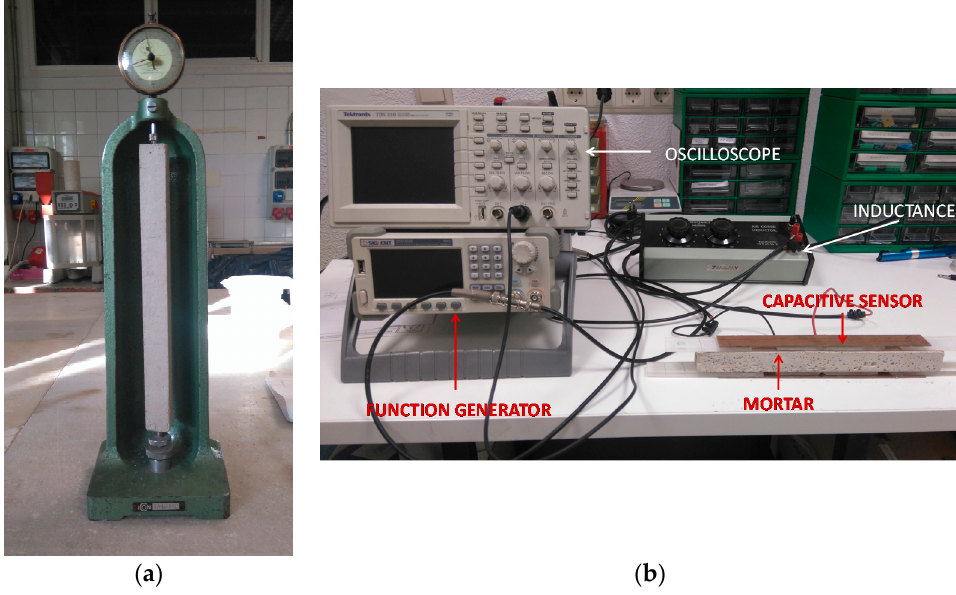
Figure 2. Measuring equipment. ( a ) Manual device of shrinkage measure; ( b ) Capacitive sensor and auto-oscillatory circuit for moisture loss measure.